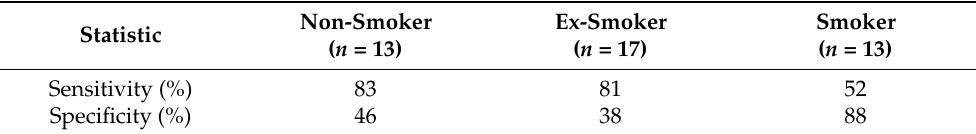
Table 3. Sensitivity and specificity values from PLSDA with LOPOCV for smoking status in epithe- lium.